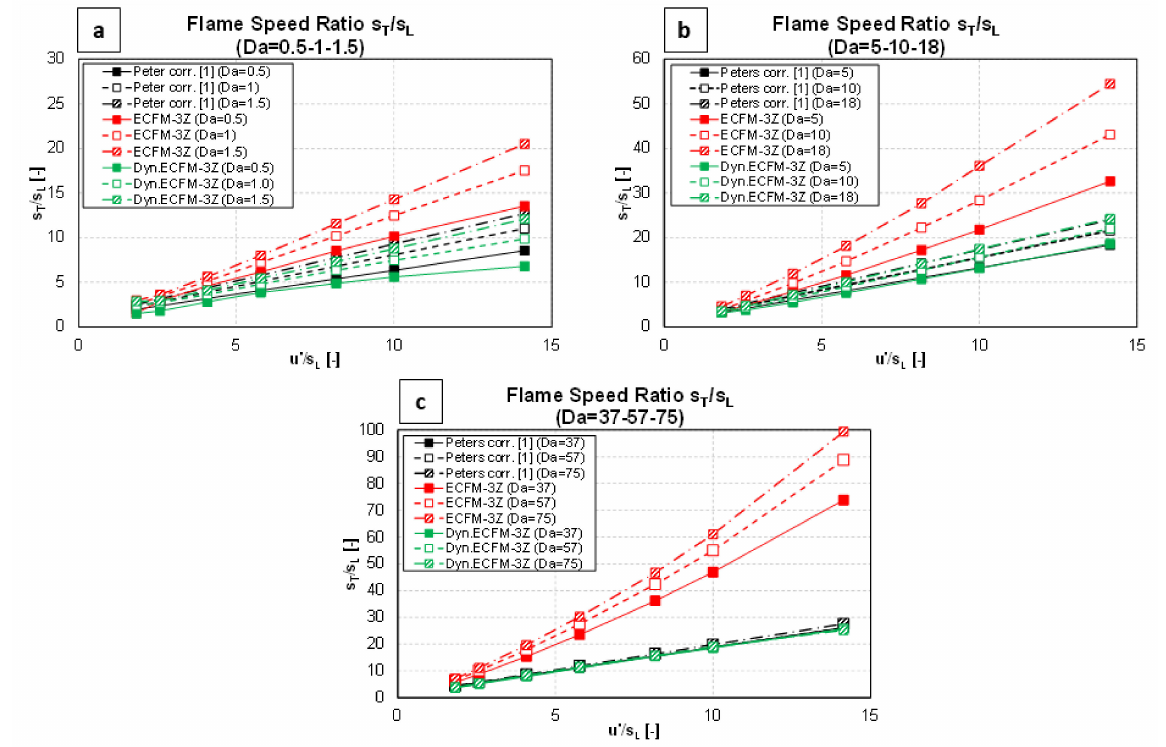
Figure 8. Flame speed ratio s T / s L as a function of u (cid:48) / s L for ECFM-3Z (Model 1): reference exp. values from Peters [1] ( s T / s ∗ , black), original ECFM-3Z results ( s T / s L , CFD , red), and dynamic ECFM-3Z results ( s T / s ∗ L = 0.5–1–1.5 ( a ), Da = 5–10–18 ( b ), and Da = 37–57–75 ( c